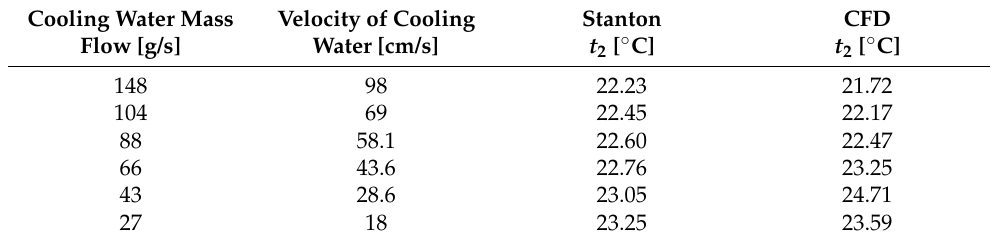
Table 1. Comparison of the experimental and numerical outlet temperature, t 2